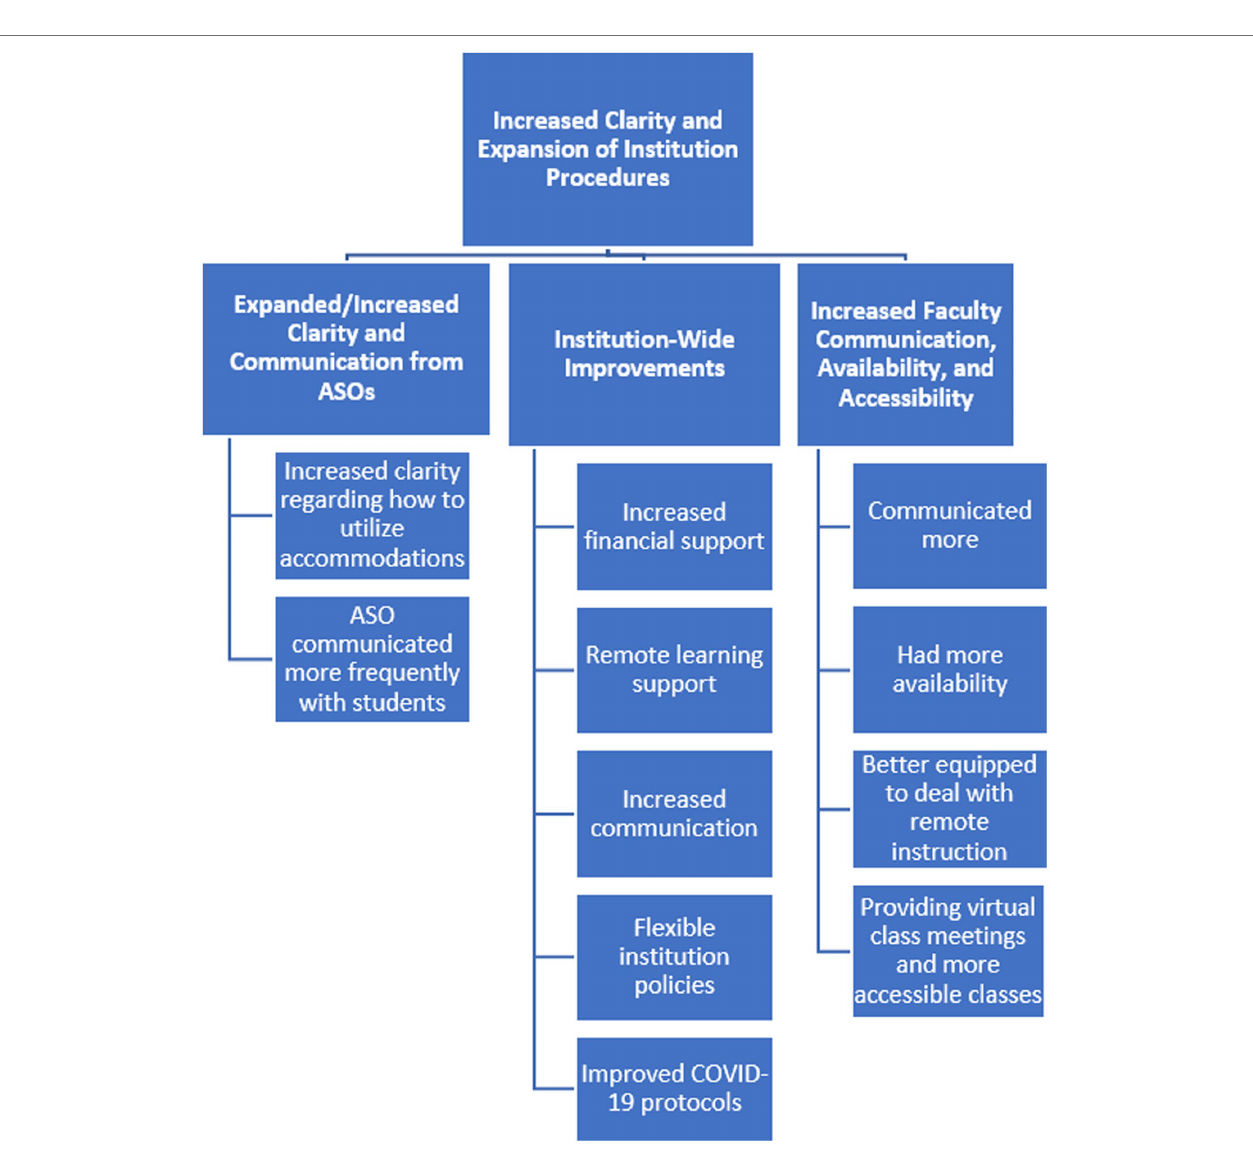
FIGURE 1 | Improvements made as Institution policy and practice adapted to the pandemic coding